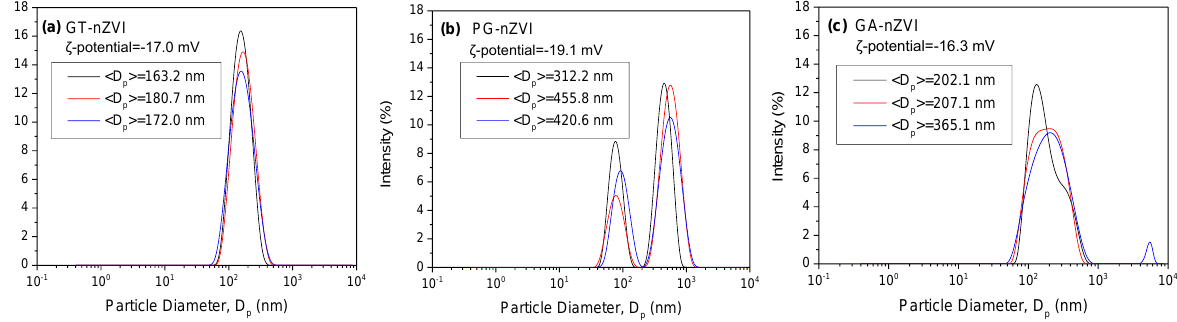
Figure 4. DLS-measured size distributions of suspended nZVI particles. For each diluted aqueous sample, three (3) measurements of the particle size statistics are done. (a) GT-nZVI; (b) PG-nZVI; (c)